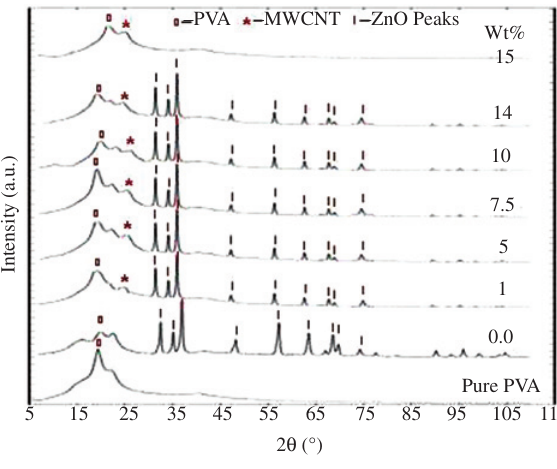
Figure 1: XRD pattern of PVA/( x )MWCNTs(15- x ) ZnO for various doping